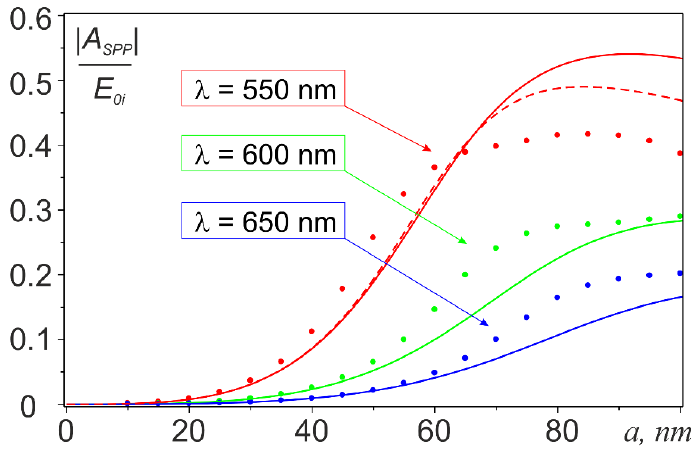
Figure 3. SPP excitation efficiency vs. nanoantenna radius at d = 10 nm. Solid curves are the results of analytical calculations; dots represent numerical data. The dashed line illustrates the correction of analytical results using the exact value of the dipole moment of the sphere in a vacuum.